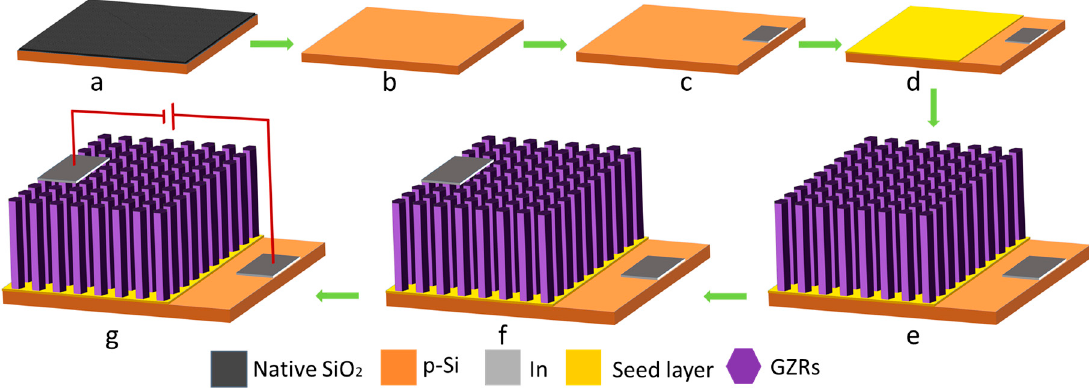
Figure 9. Device fabrication process flow diagram.